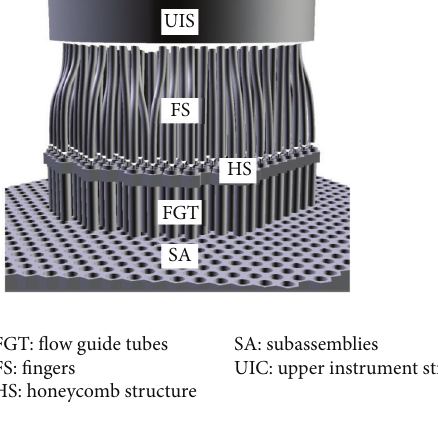
Figure 2: Sketch of the MONJU upper core structure (UCS).